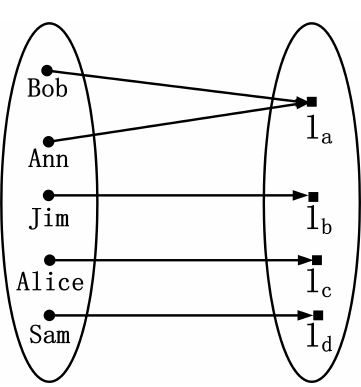
Figure 6. th k = 5 and th l =